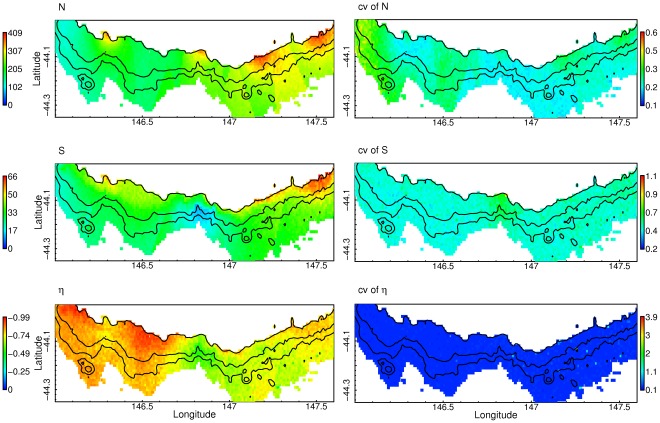
Predictions of megabenthos diversity from the deep continental margin south of Tasmania, Australia.Plots show total abundance (N) and the coefficient of variation of N; species richness (S) and the coefficient of variation of S; species evenness (η) and the coefficient of variation of evenness. A value of zero for the coefficients of variation indicates no variation around the mean prediction and a value of 1 indicates that the standard error is equal to the mean.